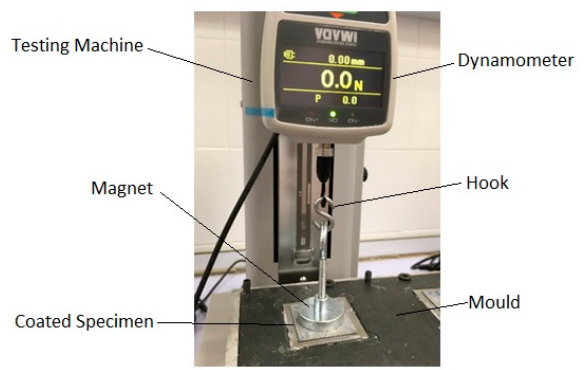
Figure 3. Setup to determine the release force in the coated specimens of 45 × 45 mm 2 .